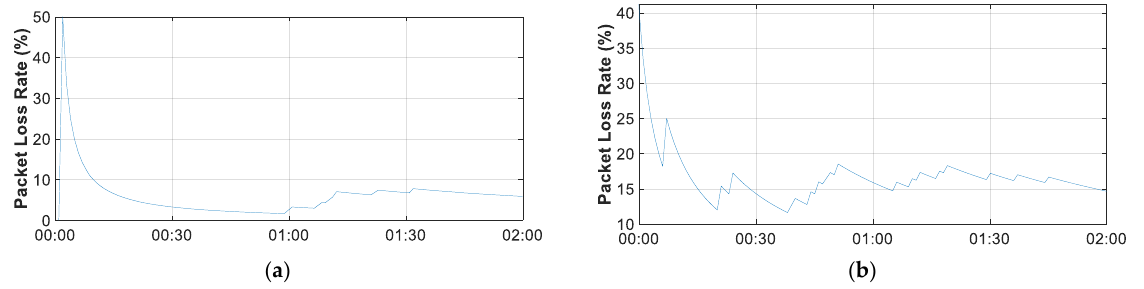
Figure 25. LoRaWAN PLR: ( a ) THMDL measurement and ( b ) ECDL measurement.